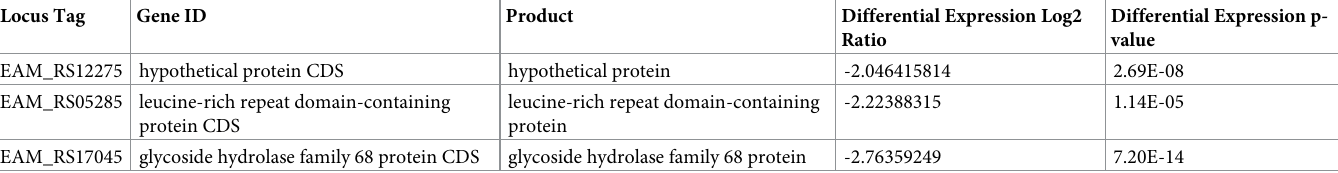
Cyclic-di-GMP dependent regulation has been studied in many bacterial systems, and the results have highlighted various signaling roles for the second messenger ranging from phase transition to bacteriophage interactions [1,2,26]. A common impediment for studying the sys- tematic impact of the genetic components of c-di-GMP metabolism has been the sheer Table 3. A list of the statistically significant differentially regulated genes (Log2 fold change of two) in Ea1189 Δ 8+ edcA OE relative to Ea1189 Δ 8. Locus